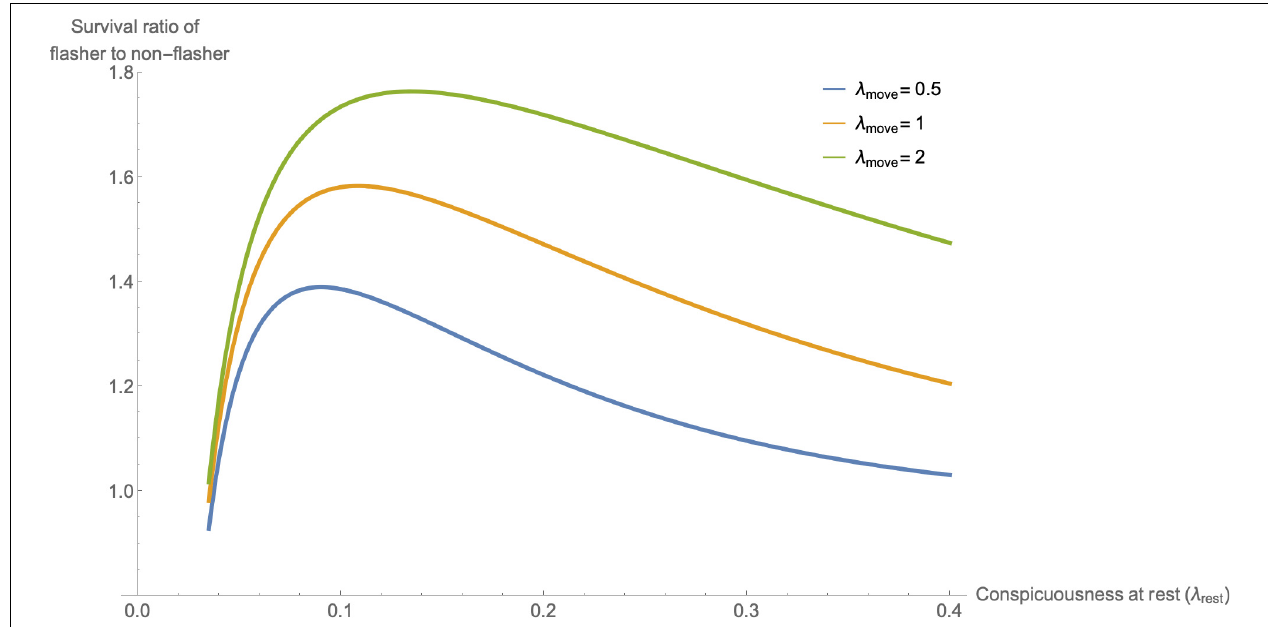
FIGURE 5 | The ratio of survival for flashers compared to non-flashers as the level of prey conspicuousness when at rest ( λ rest ) is varied (from 0.035 to 0.4). Here flashers exhibit fixed levels of the conspicuousness while moving, with λ move = 0.5, 1 or 2 and we assume g = 0.02 and p 1 = 0.6. Prey that are highly cryptic at rest have little to gain from flashing (indeed they may be harmed by having a display). Prey that are highly conspicuous at rest will be readily seen whatever the nature of their flash display, so also have little to gain from flashing. For any flash display there is an intermediate level of resting crypsis ( λ rest ) that maximizes the relative survival benefits of